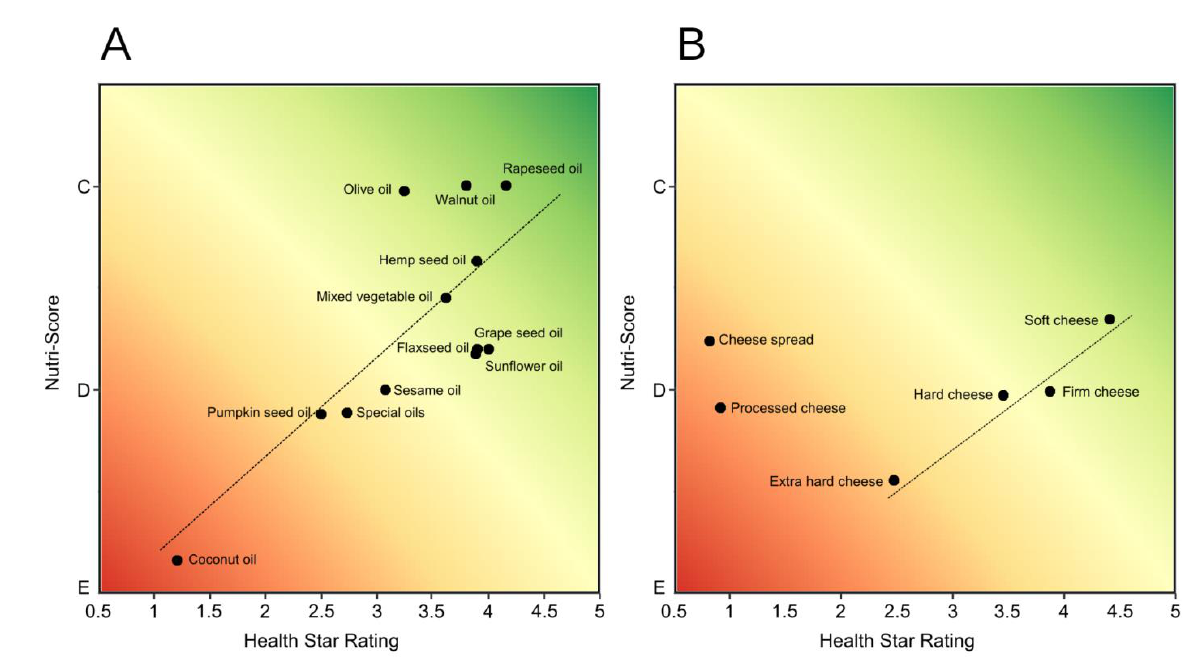
Figure 4. Average NS and HSR for different types of Cooking oils ( A ) and Cheeses ( B ). Special